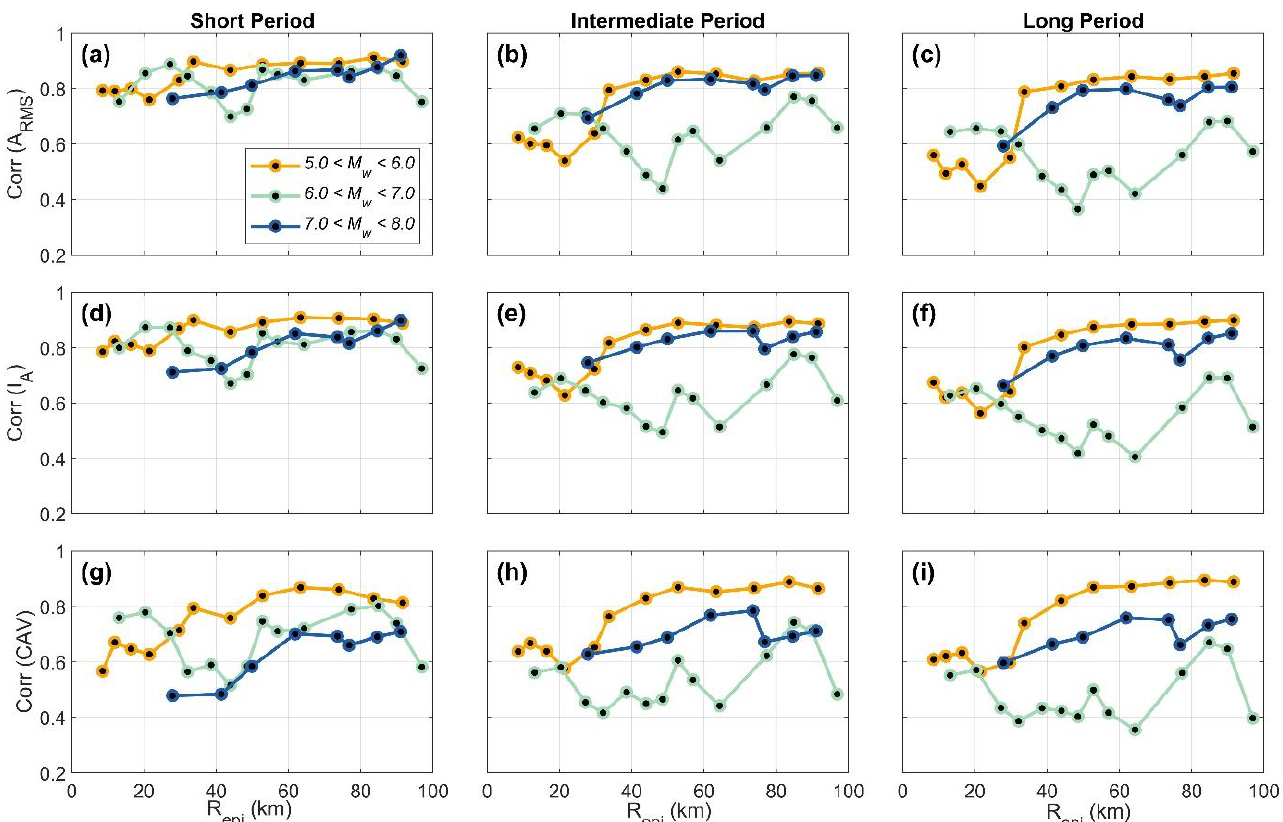
Figure 8. Distance-dependent correlations of spectral measures ( ASI , VSI , Sa(T) ) for different mag- nitude classes ( M w 5 – 6, M w 6 – 7 and M w 7 – 8) ( a – l ). Rows correspond to variations in correlations of ASI , VSI and Sa(T) for three different types of structures (SP, IP, LP). Correlations of ASI ( a – c ) and VSI ( d – f ) are almost invariant for SP and IP/LP structures, respectively, and do not show any no- ticeable magnitude dependence. Correlations of Sa(T) vary less for SP structures than IP or LP.